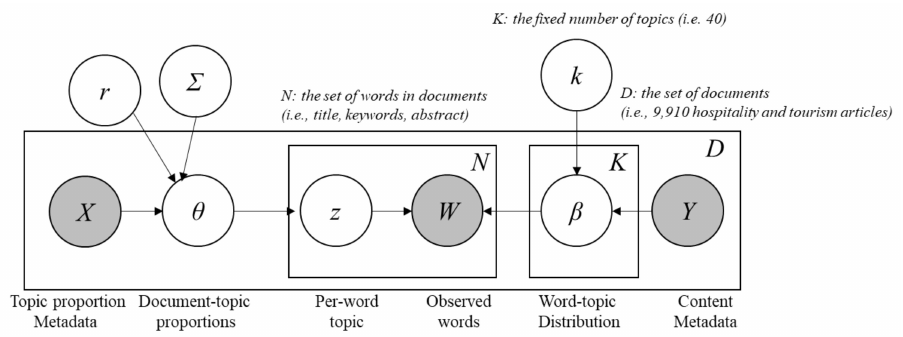
Figure 1. Illustration of STM algorithm (Adjusted from Roberts, Stewart and Airoldi